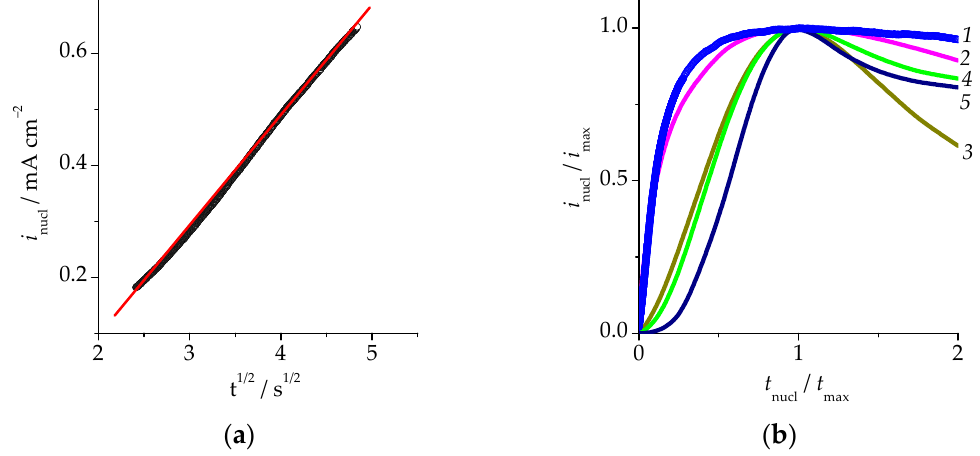
Figure 3. Current transient of palladium nucleation during overcritical selective dissolution of the Cu 85 Pd 15 alloy at the overcritical potential E mod = 630 mV: ( a )—linearization of the initial region of the nucleation chronoamperogram in criteria coordinates for the mode of instantaneous activation of the nucleation centres under diffusion-controlled growth of the 3D nucleus: black points—experimental data; red line—linear regression; ( b )—comparison of the experimental nucleation curve (1) with the theoretically calculated ones for various modes of 3D nucleation: (2)—instantaneous activation of the nucleation centres under diffusion-controlled growth of the 3D nuclei; (3)—continuous activation of the nucleation centres under diffusion-controlled growth of the 3D nuclei; (4)—instantaneous activation of the nucleation centres under kinetically controlled growth of the 3D nuclei; ( 5)—continuous activation of the nucleation centres under kinetically controlled growth of the 3D nuclei. wise scheme presented in Figure